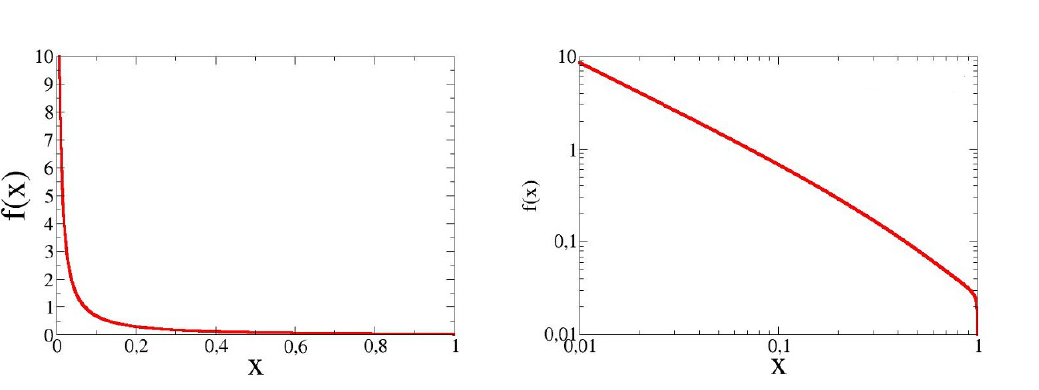
Figure 2 . Photon number density per unit x (fractional energy taken from the electron), in linear (left) and logarithmic (right) scales. We (cid:12)xed s ee to 1 TeV 2